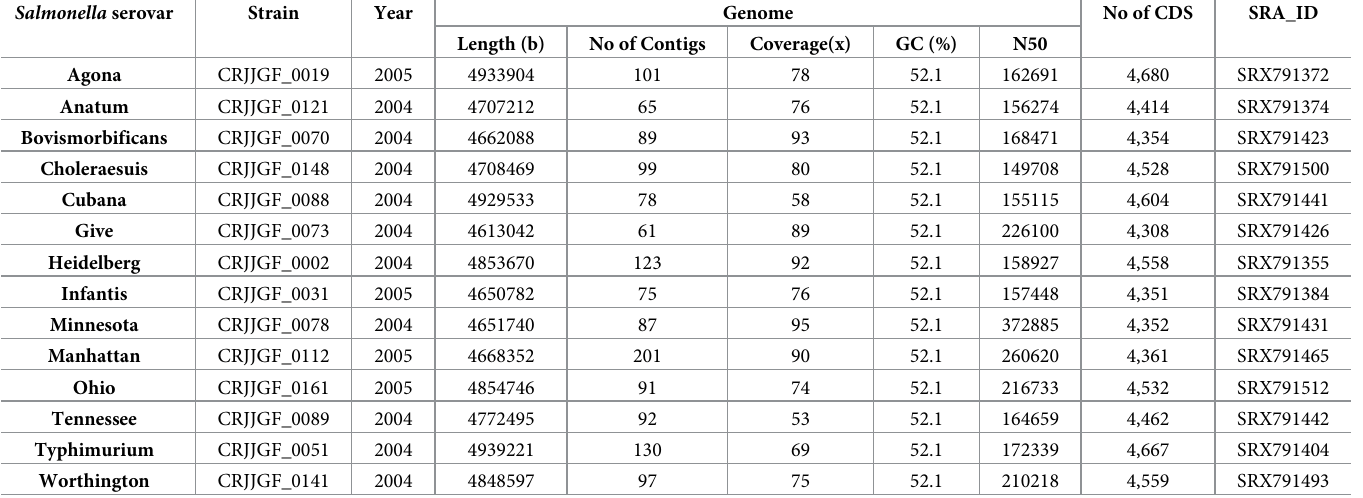
Table 1. Assembly statistics of the Salmonella enterica serovars isolated from swine and their products. Salmonella